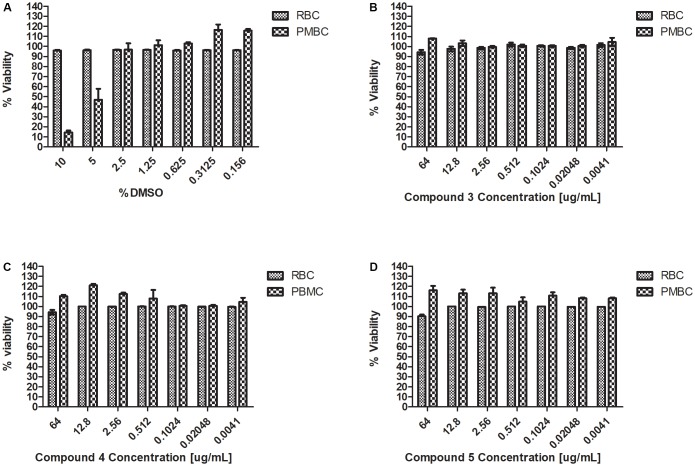
Haemolysis and cytotoxicity effects of Teixobactin derivatives at various concentrations (A) Viability (%) of RBCs and PBMCs treated with DMSO; (B) Viability (%) of RBCs and PBMCs treated with compound 3; (C) Viability (%) of RBCs and PBMCs treated with compound 4; (D) Viability (%) of RBCs and PBMCs treated with compound 5. The experiment was performed in triplicate (n = 3). The error bars indicate the standard deviation. One-way ANOVA followed by Dunnett’s test was performed to determine the significance relative to the RBC and PMBC (P < 0.05).